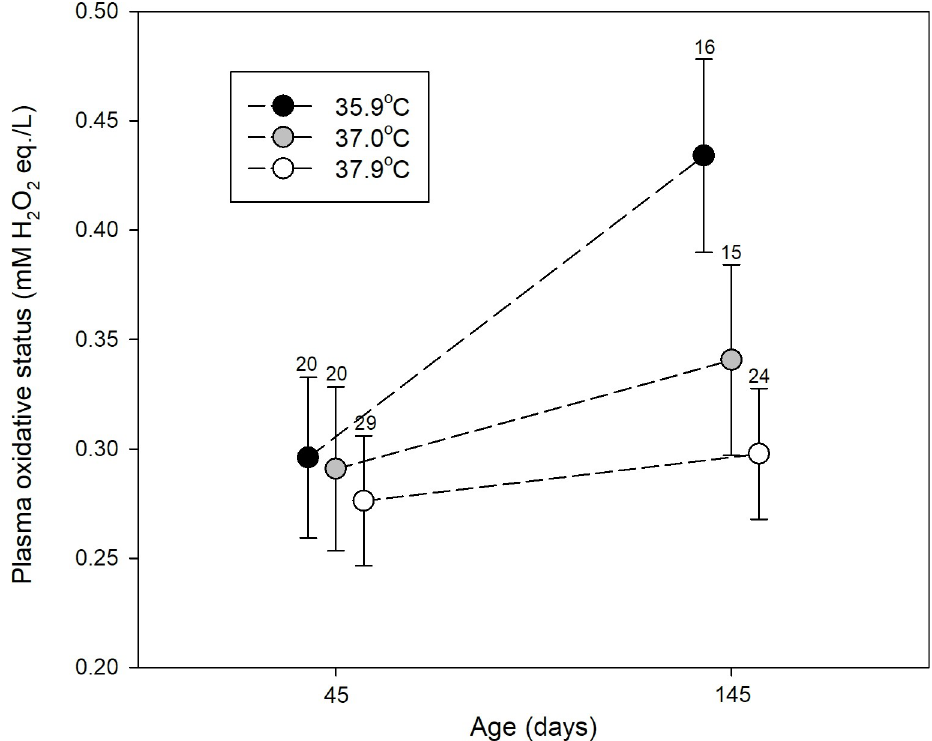
Fig 3. Changes in blood oxidative status are temperature dependent. Plasma concentration of ROMs at day 45 and day 145 for birds from eggs incubated at 35.9˚C (black), 37.0˚C (grey) and 37.9˚C (white). Shown are means ± SE. Numbers above the error bars indicate sample size.